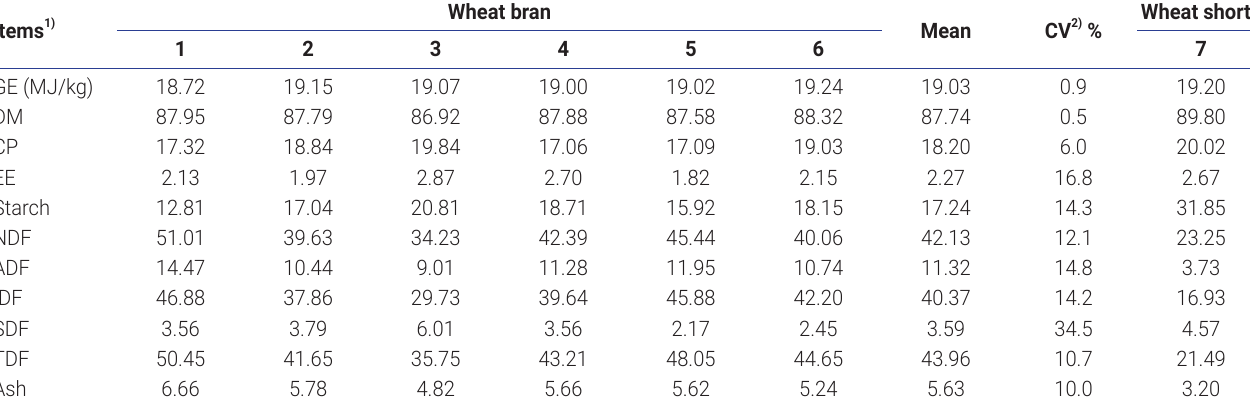
Table 1. Chemical composition of the experimental ingredients (%, DM basis) Items 1)